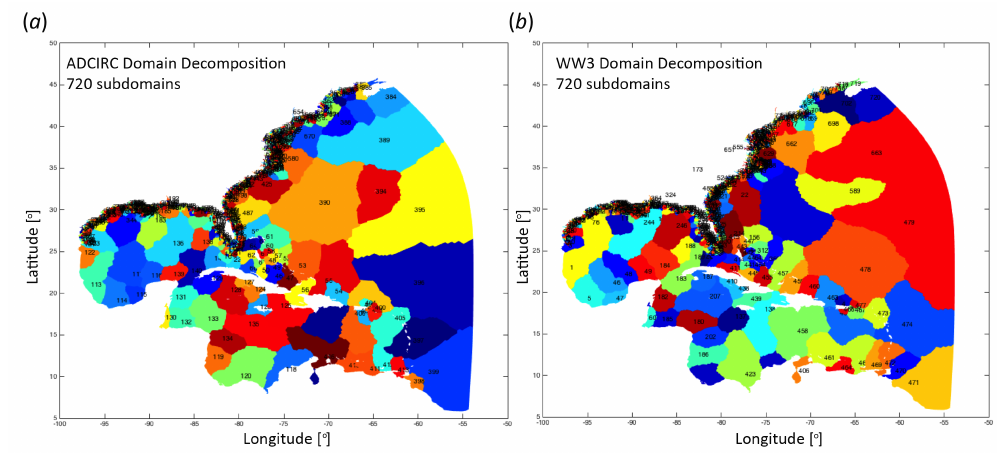
Figure 12. ADCIRC and WW3 domain decompositions for the coupled Ike, 2008 case. All model configurations and results are pre-decisional and for official use